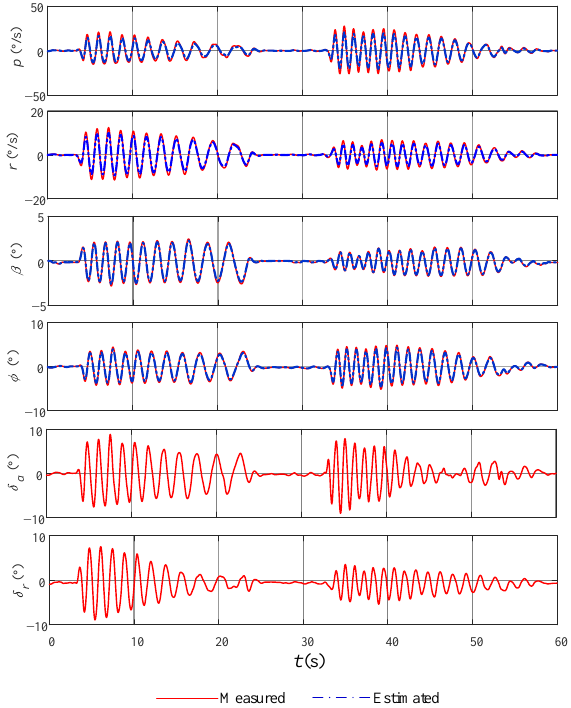
Figure 19. Comparison of simulation results for the identified model with wind tunnel test data.